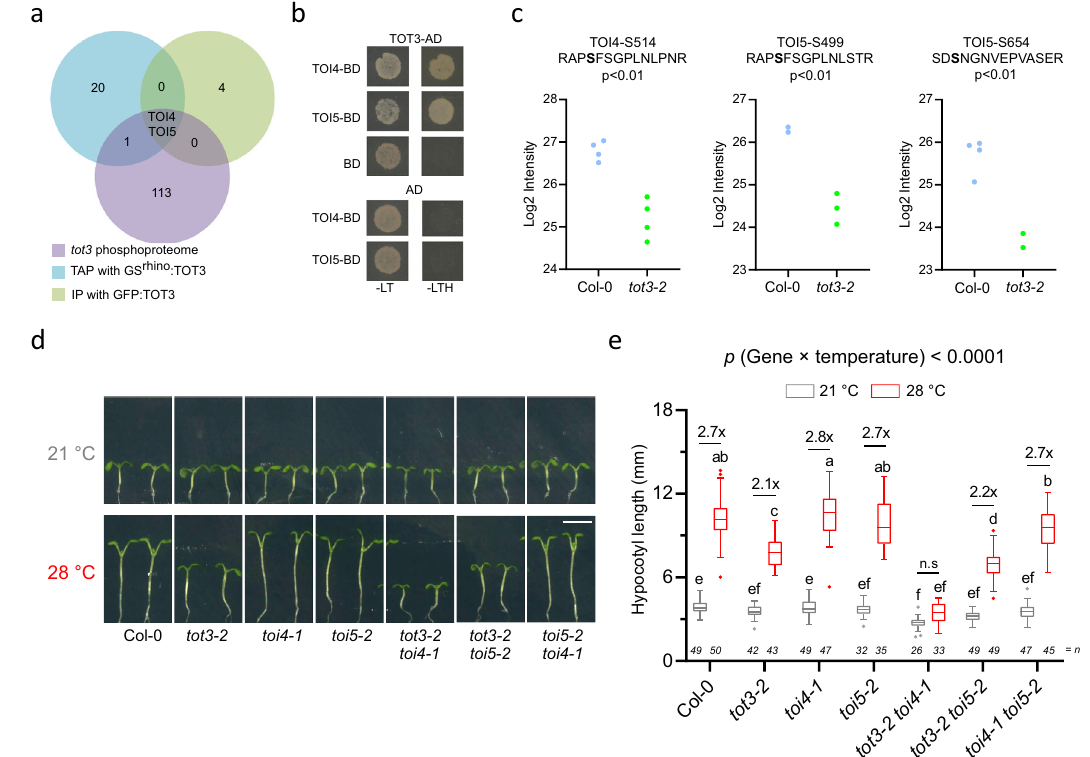
Fig. 5 Related MAP4Ks that interact with TOT3 play a role in regulating hypocotyl growth under warm temperature. a Overlap between TOT3 interactome (based on tandem af fi nity puri fi cation (TAP) and immunoprecipitation (IP)) and differentially phosphorylated proteins in tot3-2 versus Col-0 (referred to as tot3 phosphoproteome obtained from 3-day-old tot3-2 and Col-0 seedlings grown at 28 °C). b Yeast two-hybrid validation of the interaction between TOT3 and TOI4/5. BD, BINDING DOMAIN; AD, ACTIVATION DOMAIN; -LT, without Leu and Trp; -LTH, without Leu, Trp and His. c TOI4/5 phosphosites signi fi cantly deregulated in tot3 phosphoproteome. Each dot represents a biological replicate. Statistical analyses using Student ’ s t -test with two-sample unequal variance and two-tailed distribution; p -value is indicated. d , e Hypocotyl length of 7-day-old tot3 , tot3 toi4, tot3 toi5, toi4 toi5 and Col-0 plants at 21 and 28 °C in short-day conditions. Representative pictures ( d ) and hypocotyl length quanti fi cation ( e ). Scale bar, 5 mm. Box plots show median with Tukey-based whiskers and outliers. The number of individually measured seedlings ( n ) is indicated above the X -axis. Fold-change is indicated for each genotype; and letters indicate signi fi cant differences based on two-way ANOVA and Tukey ’ s test ( p < 0.01) ( e ). The p -value for the interaction (genotype × temperature) is shown at the